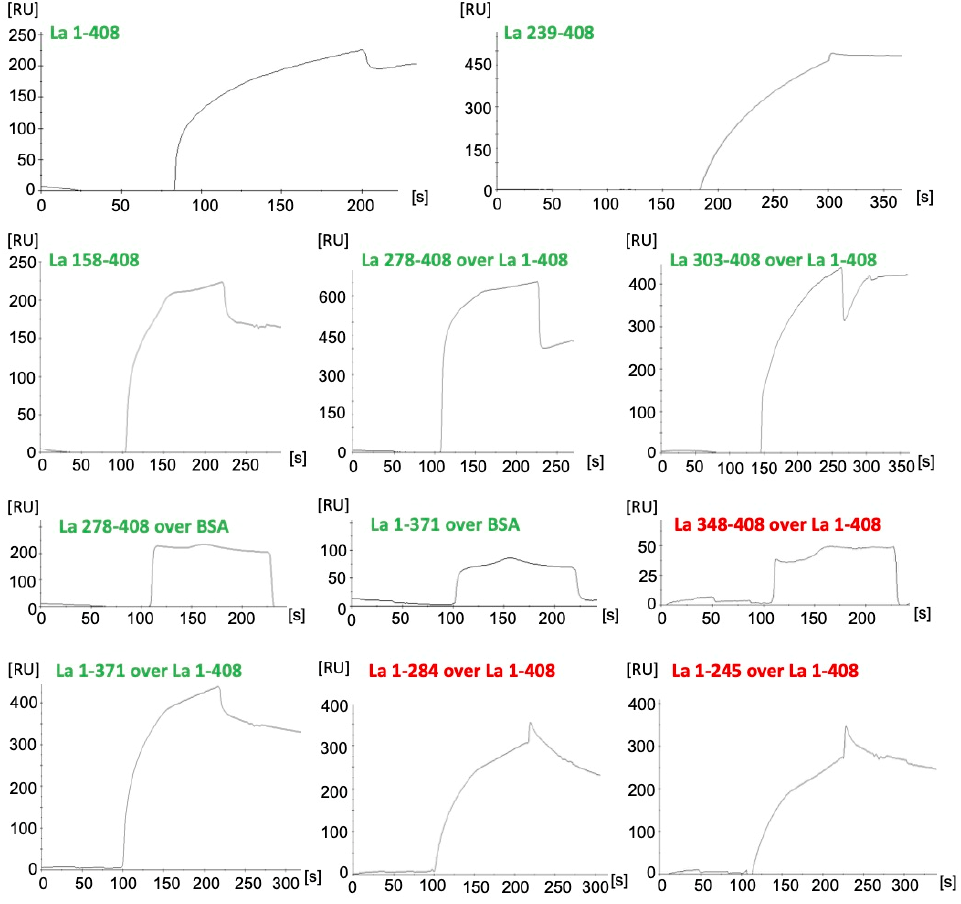
Figure 6. SPR studies to confirm La protein–protein interactions. Wildtype La protein was covalently linked to a sensor chip. Binding of full-length La protein (La 1-408) or N- or C-terminally truncated deletion mutants containing (highlighted in green) or lacking (highlighted in red) the identified Dim domain were tested for binding. As negative control served a sensor chip to which bovine serum albumin (BSA) was coupled.